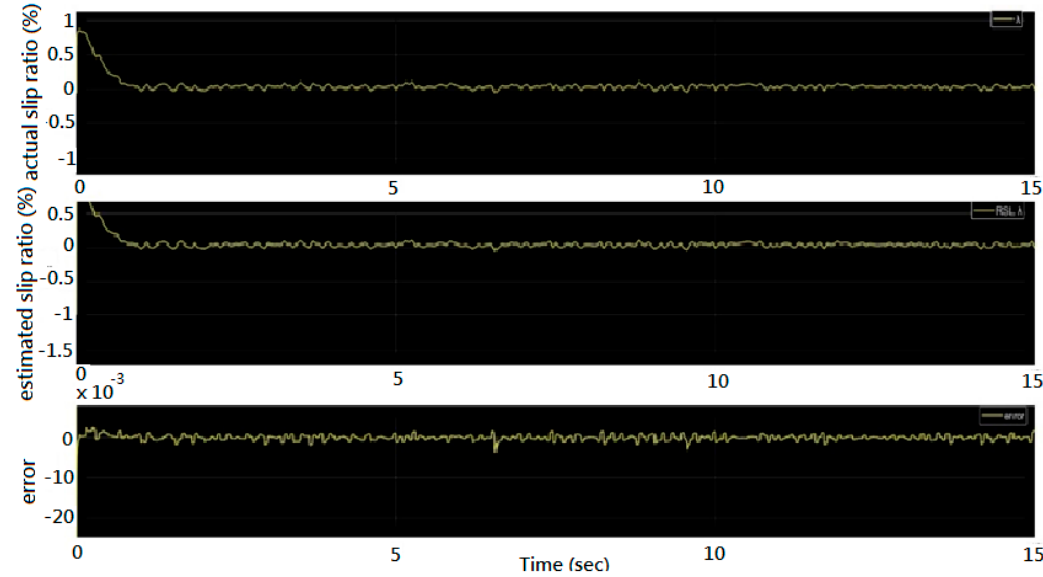
Figure 11. The actual slip ratio (top), the estimated slip ratio (middle), and difference (bottom) of the fourth motor.